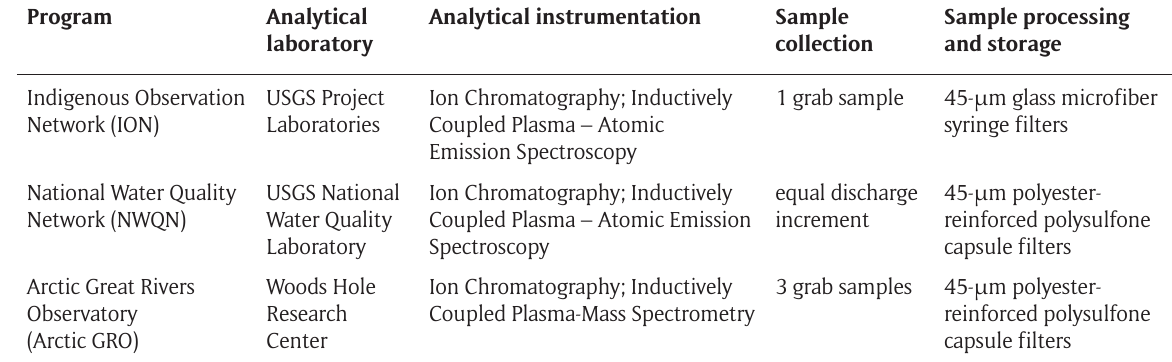
Table 1: Summary of protocols, laboratories, and equipment for each program discussed in this paper. All three programs used high-density polyethylene storage